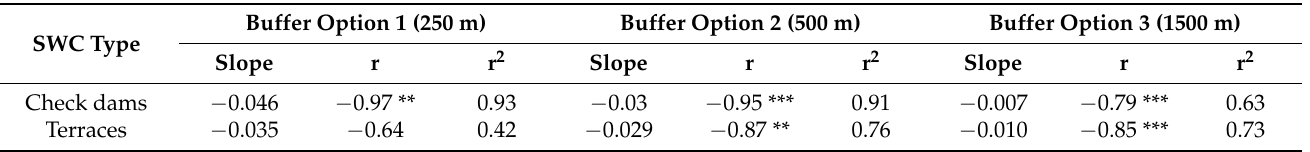
Table 2. Regional OLS regression results for the proportion of significant positive trends in the period 2011–2018.